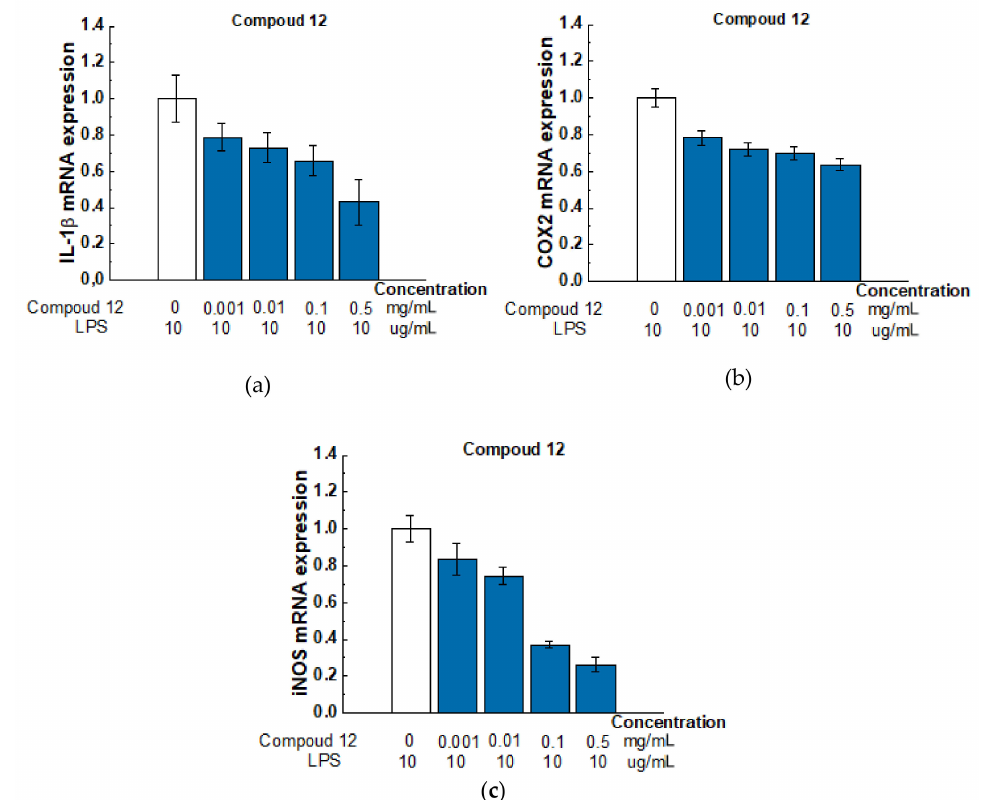
Figure 9. Effect of compound 12 on the expression level of IL-1 β ( a ), COX-2 ( b ), and iNOS ( c ) mRNA in LPS-activated Raw 264.7 cells. Raw 264.7 cells were pretreated with LPS (10 µ g/mL) for 18 h followed by the addition of Compound 12 at concentrations of 0.001, 0.01, 0.1, and 0.5 mg/mL for 6 h. mRNA levels were analyzed with real-time PCR. The results are the relative levels of mRNA expression, which were normalized relative to the reference gene (Rpl27). Data are presented as mean and SD ( n =